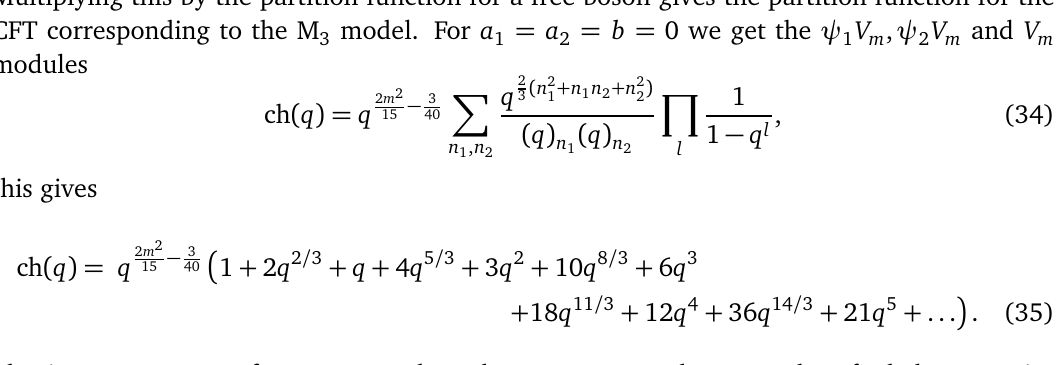
Figure 2: The complete spectrum of the CFT corresponding to the M states are for length L = 5 j open / open